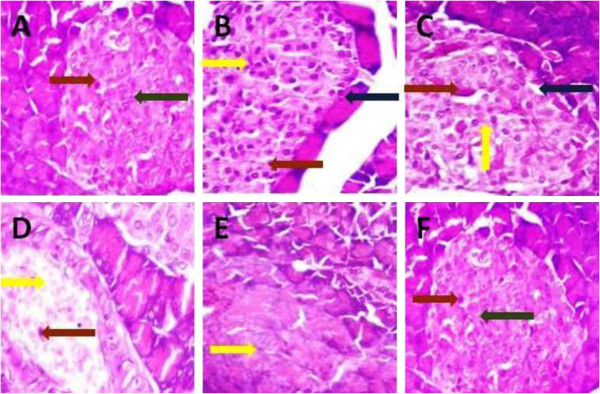
Photomicrographs of histological changes of rat pancreata (A) Normal control: Normal histological structure of rat pancreata showed averaged sized islet (red arrow) and normal sized β cells (green arrow) (B) Diabetic control: Diabetic control rat showing rat pancreata small sized (red arrow) without enlargement of β cells (yellow arrow) and showing the changes of fatty acid (blue arrow) (C) MM I (100 mg/kg): tested drug rat showing rat pancreata small sized (red arrow) without enlargement of β cells (yellow arrow) and showing the less changes of fatty acid (blue arrow) (D) MM II (250 mg/kg): tested drug rat showing rat showing rat pancreata small sized (red arrow) without enlargement of β cells (yellow arrow) (E) MM III (500 mg/kg): tested drug rat showing rat enlargement of β cells (yellow arrow) (F) Glibenclamide (10 mg/kg): glibenclamide treated rat histological structure of rat pancreata showed averaged sized islet (red arrow) and normal sized β cells (green arrow). For each group 6 rats were examined and 50 pictures were taken. The above picture for each group was chosen randomly from the 80 pictures in this group. Original magnification, 40 ×.